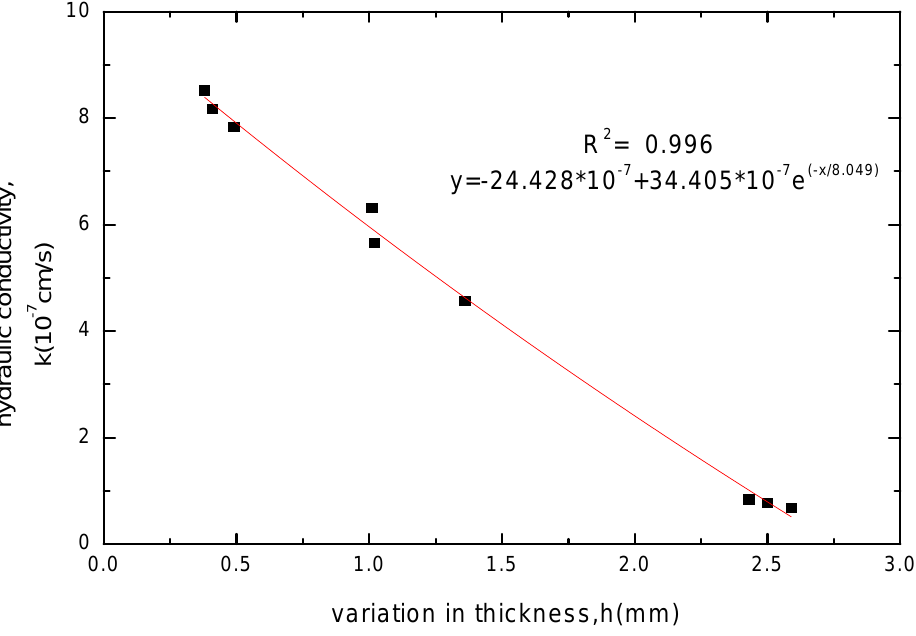
Figure 9. The relationship between hydraulic conductivity and thickness increase for GCL specimens soaked with MgCl solution. 2